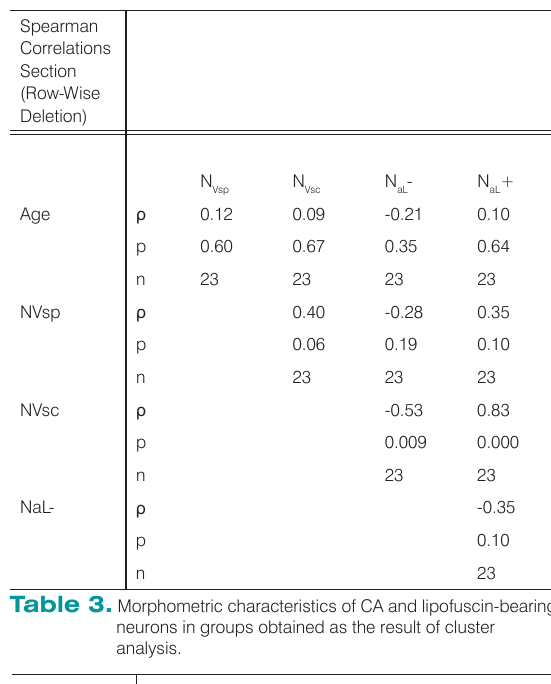
Table 2. Correlation matrix between the age, numerical density of subpial CA, numerical density of subcortical CA, number of lipofuscin-bearing and number of lipofuscin-free neurons.